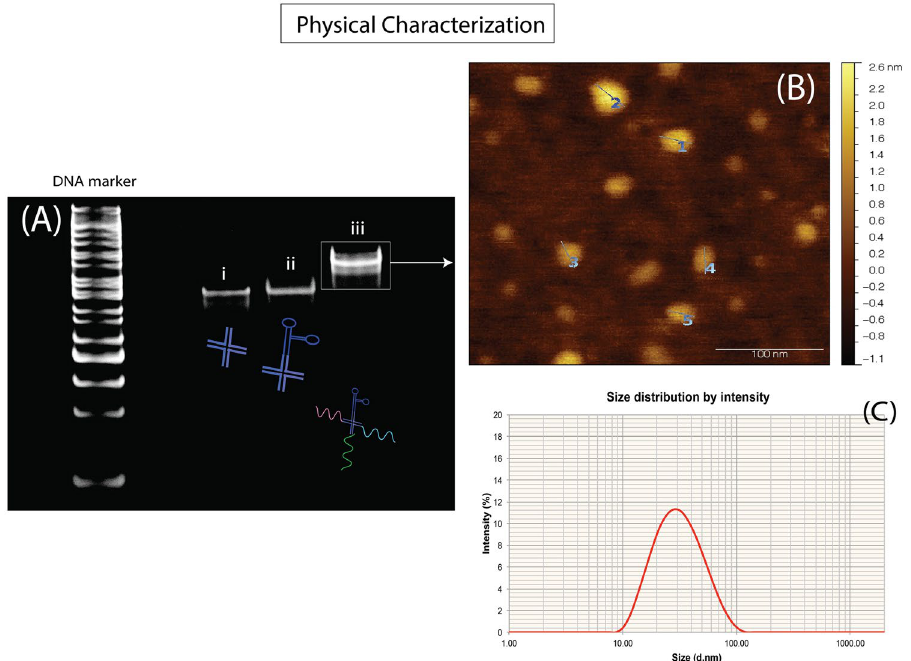
Figure 2. ( A ) Acrylamide gel electrophoresis and staining of the nanoconstruct (i) the four arms holliday junction strands without the aptamer, (ii) nanoconstruct with the aptamer strand and (iii) nanoconstruct with aptamer as well as all three antisense RNA hybridized to the overhanging sequences. Atomic force microscopy ( B ) and dynamic light scattering ( C ) had revealed that the nanoconstruct was approximately 28.64 ± 2.53